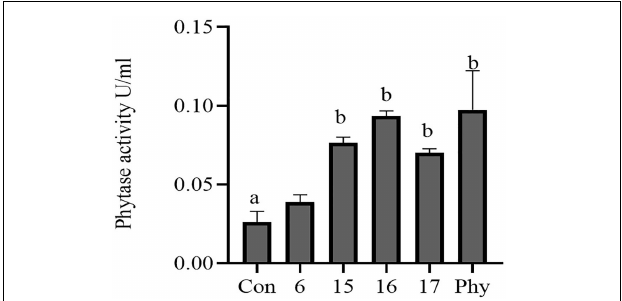
FIGURE 2 | Phytase activity in four selected phytate-degrading strains was assayed. The supernatant of the cultured strains was assayed for phytase activity using a phytase assay kit. Con, MRS; 6, psm 6; 15, psm 15; 16, psm16; 17, psm17; Phy, Phytase. Differences in the bar are not significant without marked letters ( p > 0.05). a, b values that do not share a common letter in the bar graph above differ significantly ( p <